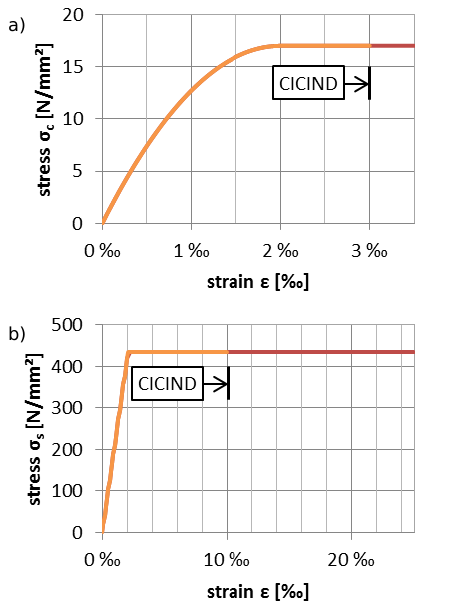
Figure 2. Stress-strain-curves of concrete (a) and reinforcement (b) acc. to [4], with reduced strain limits acc. to [2].